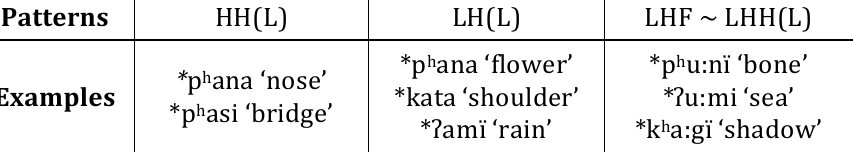
Table 5: Ryukyuan pitch accent in disyllabic nouns (H = high tone, L = low tone, F = falling tone)